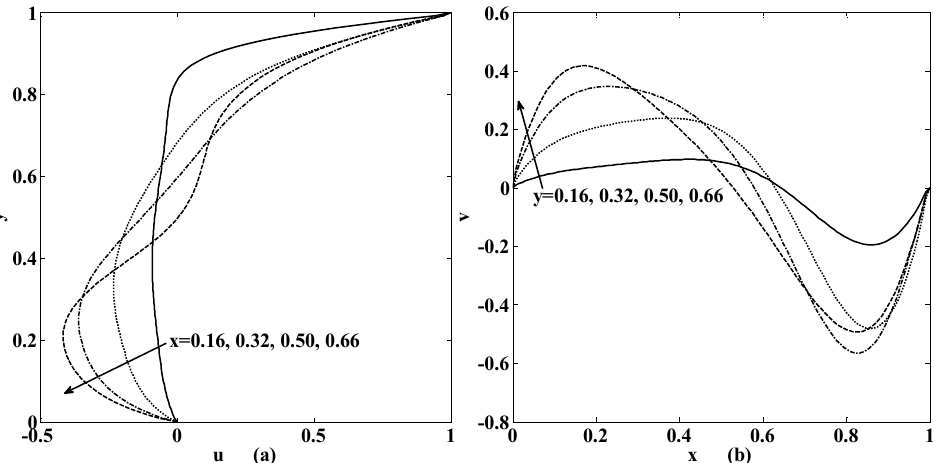
Figure 7. Variation of velocity ( a ) u ( x , y ) ; ( b ) v ( x , y ) , at the di ff erent positions in the cavity as mentioned (cid:110) (cid:111) = { 0.001, 10, 0, 1 } S t , R , α p , γ within the figure if